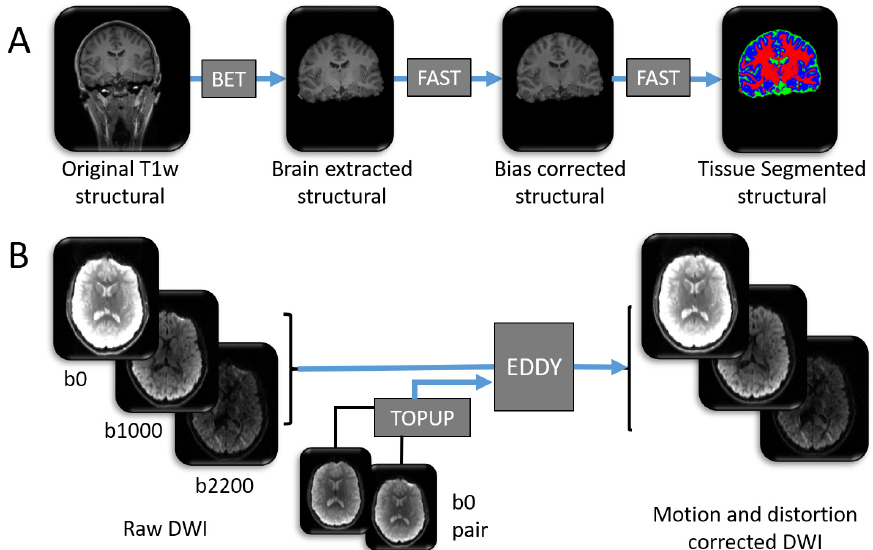
Figure 1. Graphical representation of the structural MRI data analysis pipelines. A summary of the data processing tools used to prepare the ( A ) T1 weighted image and ( B ) diffusion weighted image for further analysis. Blue arrows denote pre-processing steps using freely available online tools (named within dark grey boxes). All pictures are of 3 dimensional images from one participant, and represent examples of input and output data files. As part of process ( A ), each high resolution T1 weighted structural image has (i) non-brain tissue removed using BET, (ii) spatial intensity variations (RF field inhomogeneity) corrected using FAST and (iii) brain tissue types automatically labelled to one of either grey matter, white matter or cerebrospinal fluid (CSF) using FAST. Blue = grey matter, red = white matter, green = CSF. High resolution structural images are shown in greyscale. Note: this figure does not contain all input files and options required for each tool. For a comprehensive list of inputs, see the scripts that accompany this analysis 70